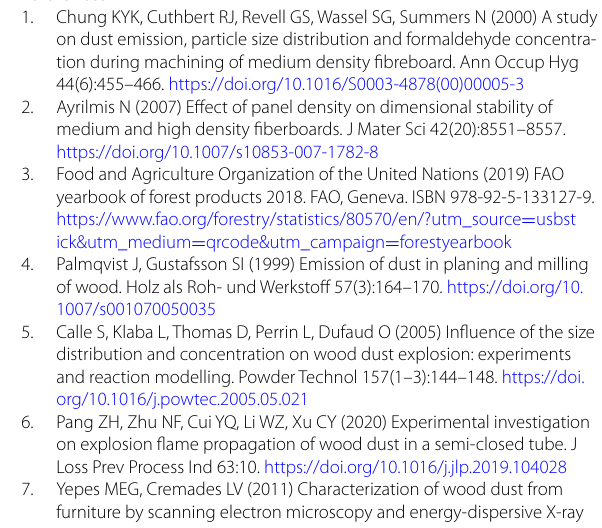
35 μm and AR 0.71; b fiber bundles fractured by tool = =